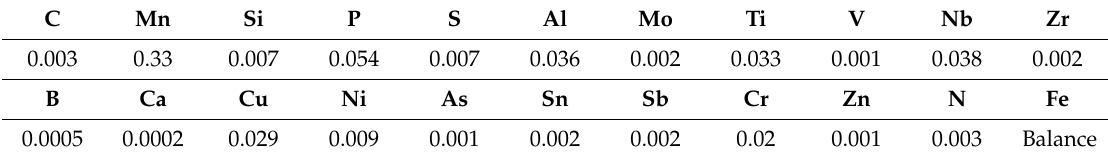
Table 1. Chemical composition of the slab cast at the standard pulling rate 1.02 m / min [wt.